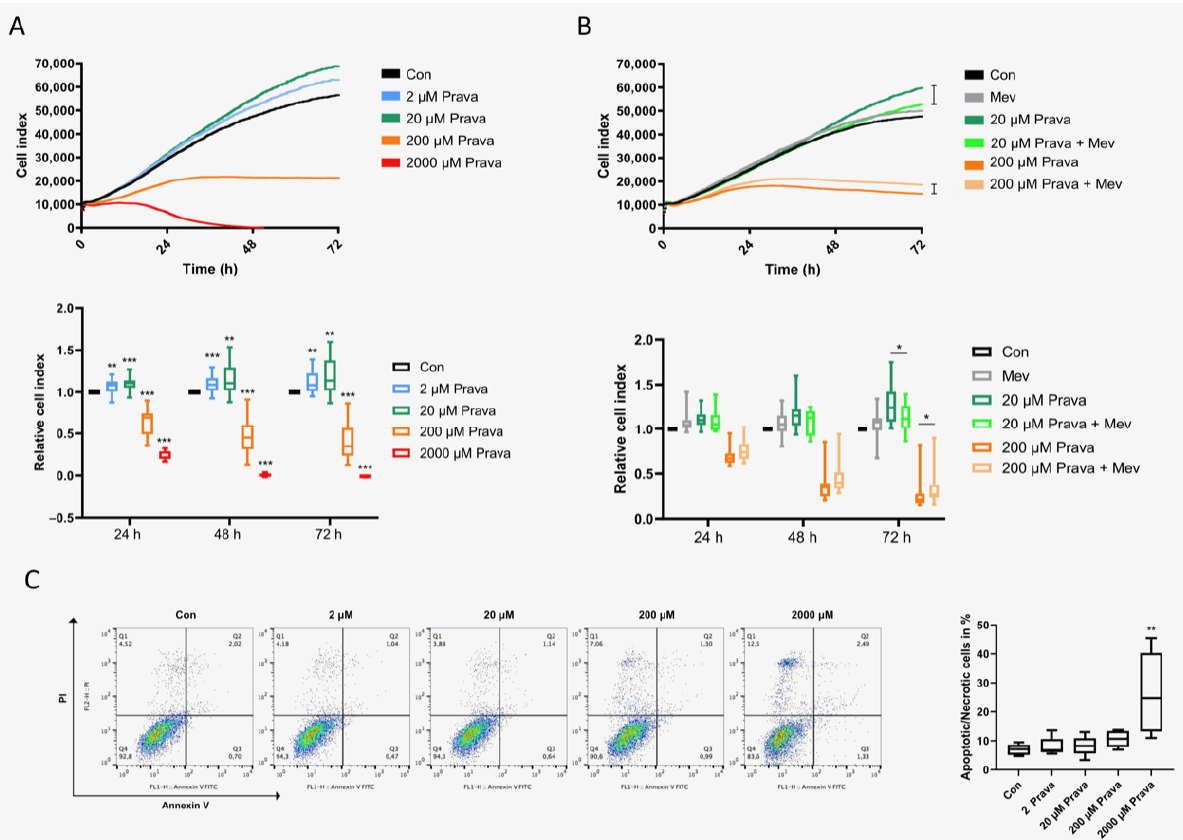
Figure 3. Pravastatin had a biphasic impact on ECFC proliferation. ( A ) Overlay of growth curves of ECFCs treated with pravastatin (2 µ M, 20 µ M, 200 µ M or 2000 µ M). ECFC proliferation was significantly increased after treatment with 2 µ M or 20 µ M pravastatin, but significantly decreased after treatment with 200 µ M or 2000 µ M pravastatin after 24 h, 48 h and 72 h. ( B ) Overlay of growth curves of ECFCs treated with 20 µ M or 200 µ M pravastatin in the presence or absence of 200 µ M mevalonate. Mevalonate reduced the proliferative effect of 20 µ M pravastatin and lessened the antiproliferative effect of 200 µ M pravastatin significantly after 72 h. n = 15–20; control group set as 1. ( C ) High dose pravastatin led to apoptosis. Representative measurement of apoptosis and necrosis in ECFCs after 48 h treatment with pravastatin at 2 µ M, 20 µ M, 200 µ M or 2000 µ M. Viable cells are located in the lower left field (Annexin V neg./PI neg). Pravastatin (2000 µ M) caused a significantly higher rate of non-viable cells. n = 5. Con, control; Prava, pravastatin; Mev, mevalonate. * p < 0.05, ** p < 0.01, *** p <